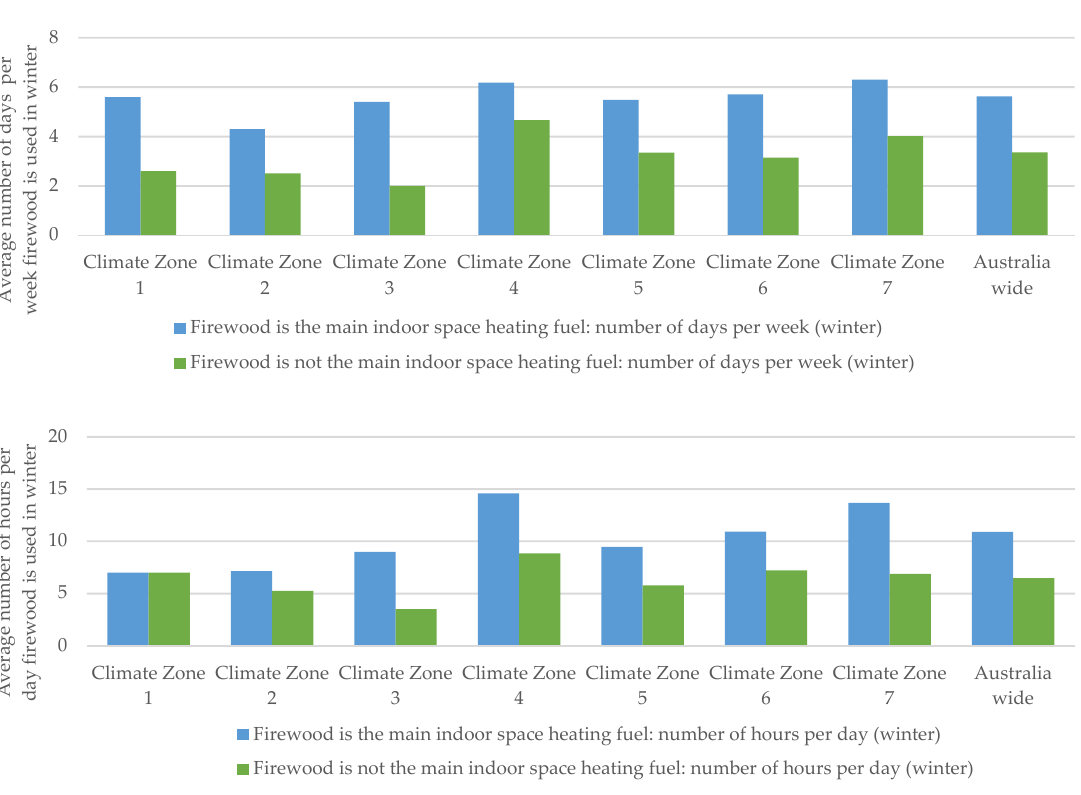
Figure 4. Frequency and duration of firewood use for indoor space heating for each state or territory (n~937).